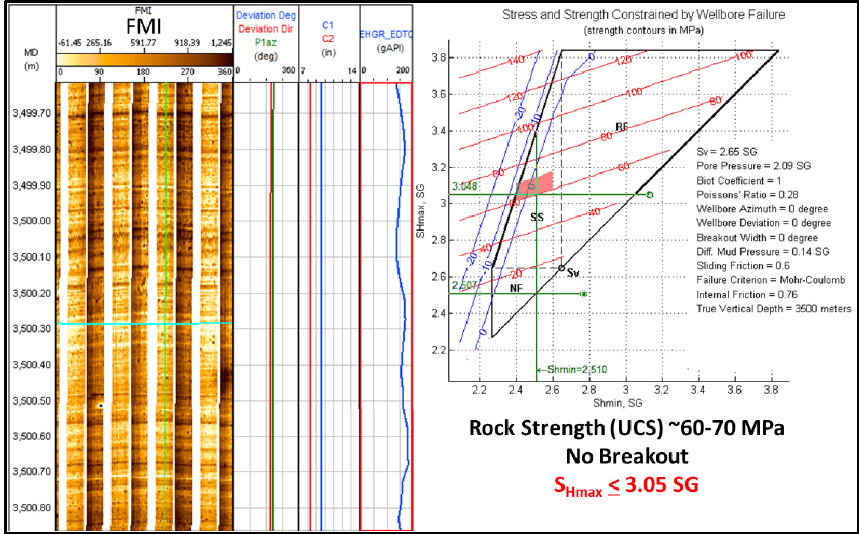
Figure 19. S Hmax magnitude determination of W205 at 3500 m TVD.